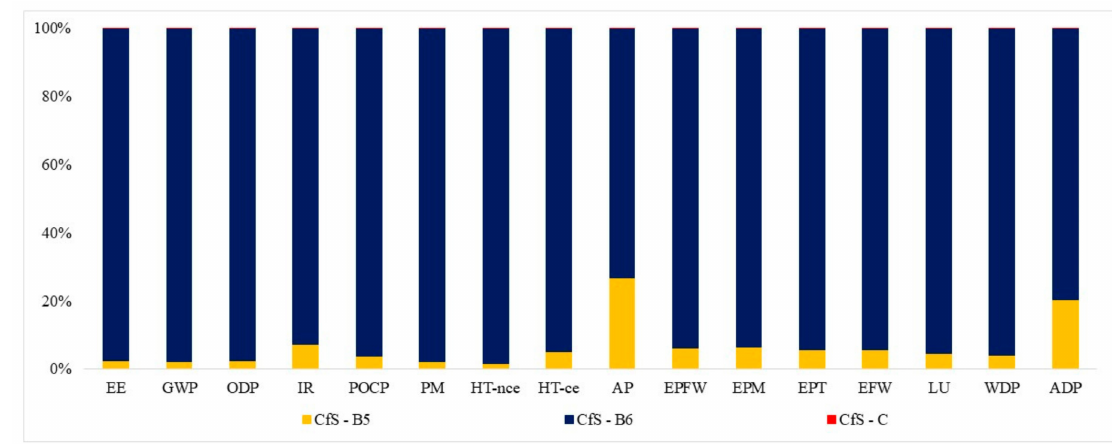
Figure A5. Contribution of the different phases to the life cycle impacts—CfS (1970–1989).